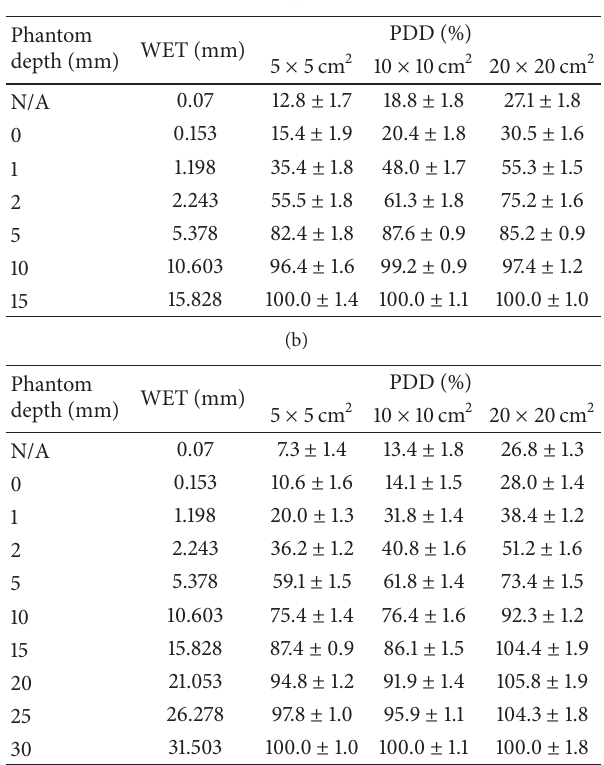
Table 3: (a) Percentage depth doses (PDDs) obtained with a MOSFET dosimeter in a water equivalent RW3 phantom using 6 MV photon beams for different field sizes at SSD = 100 cm. (b) Percentagedepthdoses(PDDs)obtainedwithaMOSFETdosimeter in a water equivalent RW3 phantom using 15MV photon beams for different field sizes at SSD = 100cm.